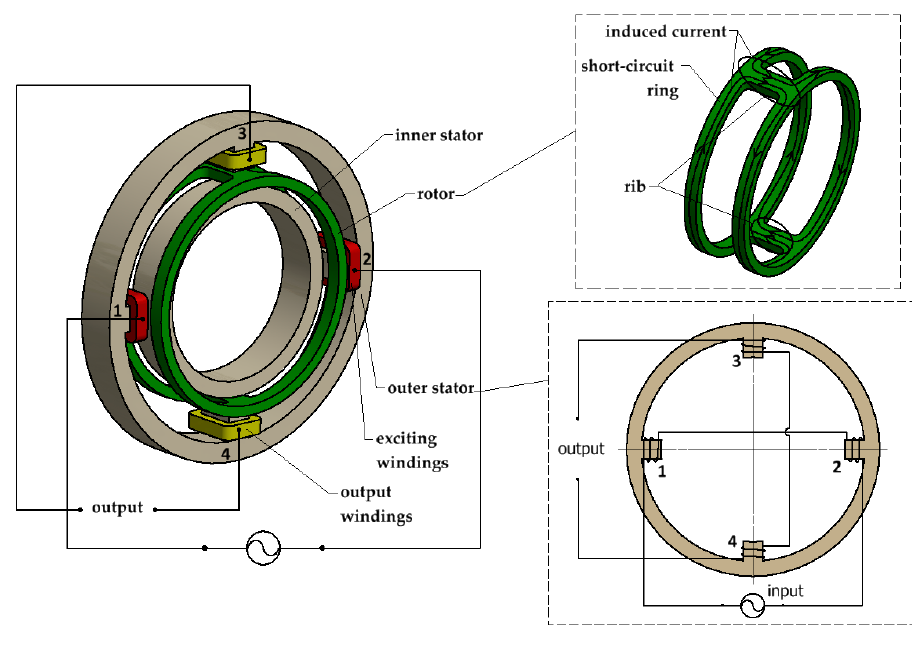
Figure 1. Schematics of the basic structure and windings connection of the transducer.